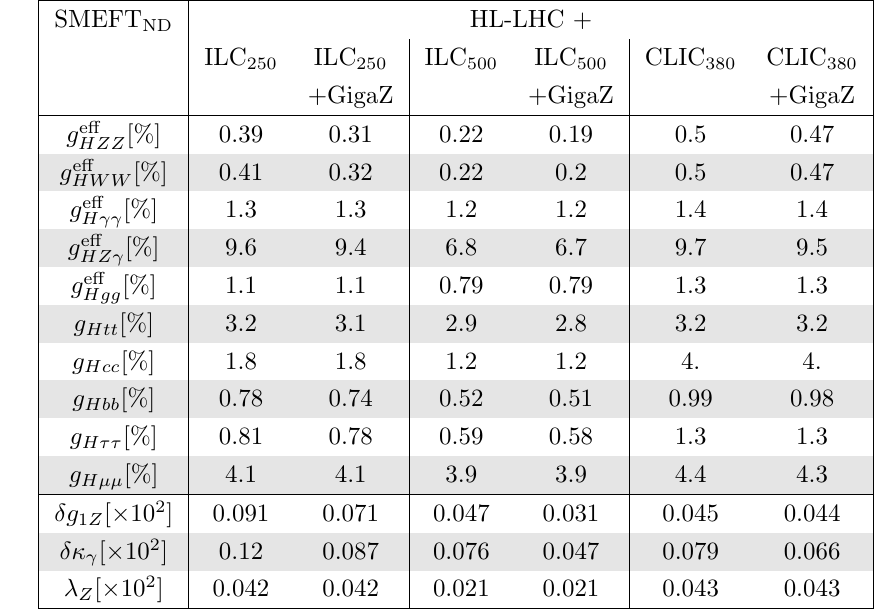
Table 33 . Comparison of the e(cid:11)ective Higgs coupling sensitivities for the ILC and CLIC with and p without a dedicated running at s (cid:25) M Z